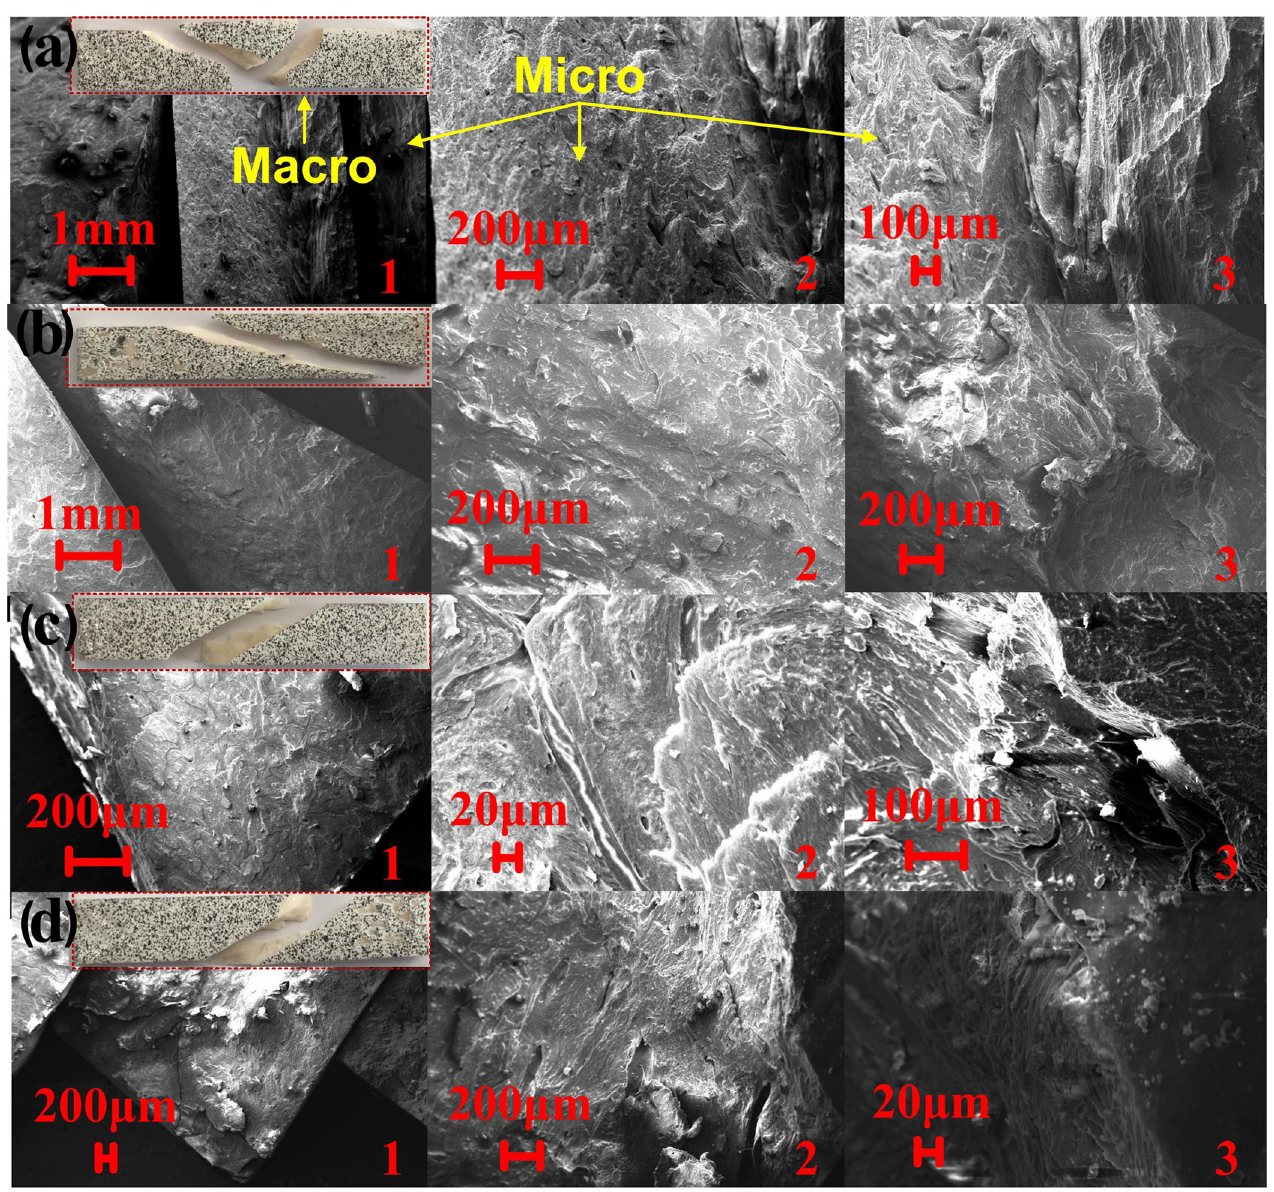
Fig 8. Macro and micro fracture morphology with different compression load (a) No compression, torsion speed 0.3˚/s (b) 500N compression, torsion speed 0.3˚/s (c) 1000N compression, torsion speed 0.3˚/s (d) 1500N compression, torsion speed 0.3˚/s.